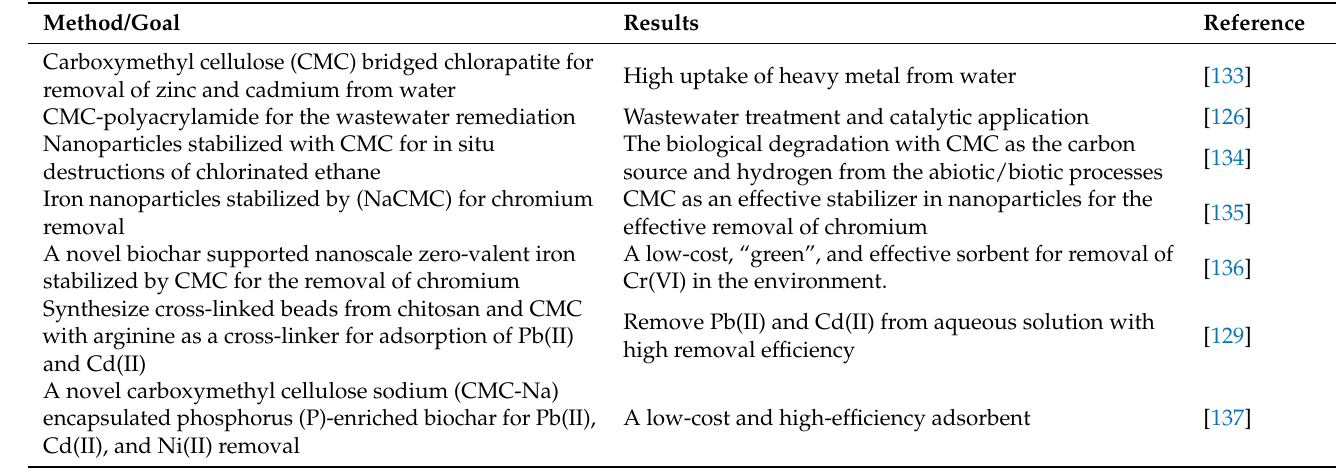
Table 6. Remediation and heavy metals removal by